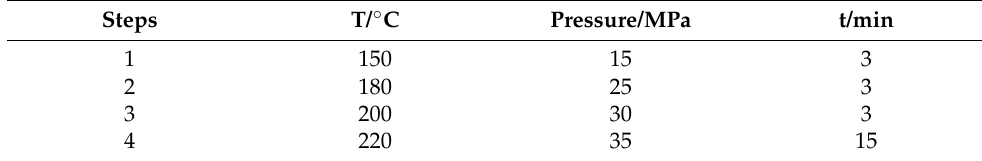
Table 1. Microwave digestion conditions.